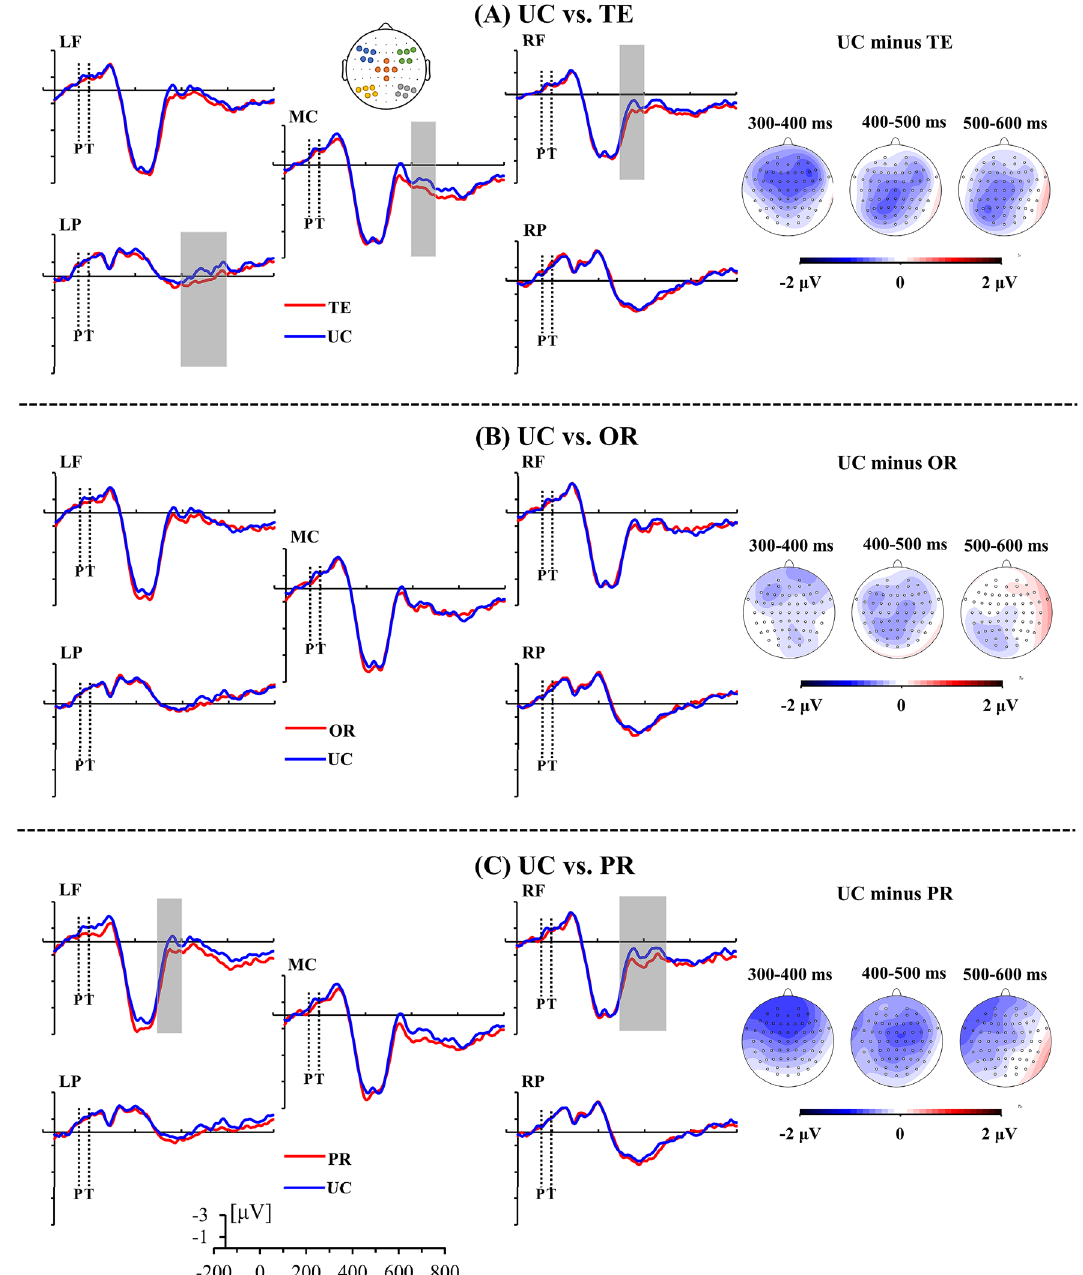
Figure 2. Grand averaged ERP waveforms elicited by unrelated control (UC, blue line) condition paired with ( A ) translation equivalent (TE, red line) condition, ( B ) orthographically related through translation (OR, red line) condition, and ( C ) phonologically related through translation condition (PR, red line). The gray rectangles indicate significant ERP differences across time windows and scalp regions analyzed ( p < 0.05). The scalp voltage maps on the right correspond to the difference waves of unrelated control minus translation-related priming conditions in the 300–600 ms. Note P = prime, T = target; LF = left frontal, RF = right frontal, MC = middle central, LP = left parietal, RP = right